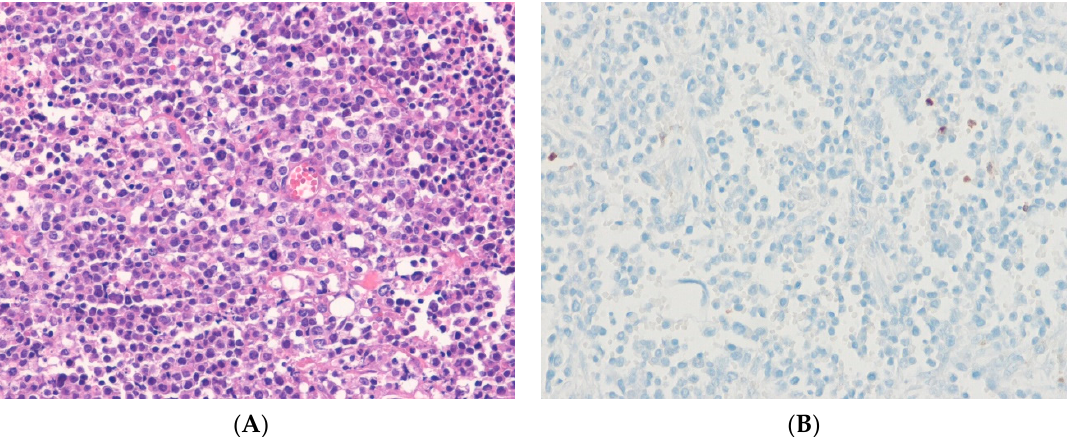
Figure 10. Thoracic SMARCA4-de fi cient undi ff erentiated tumor. ( A ) The tumor shows di ff use sheets of epithelioid tumor cells with uniform round nuclei and prominent nucleoli (H&E stain, ×200). ( B ) Most tumor cells show complete loss of SMARCA4, indicating the presence of underlying SMARCA4 inactivation (immunohistochemical stain for SMARCA4, ×200).